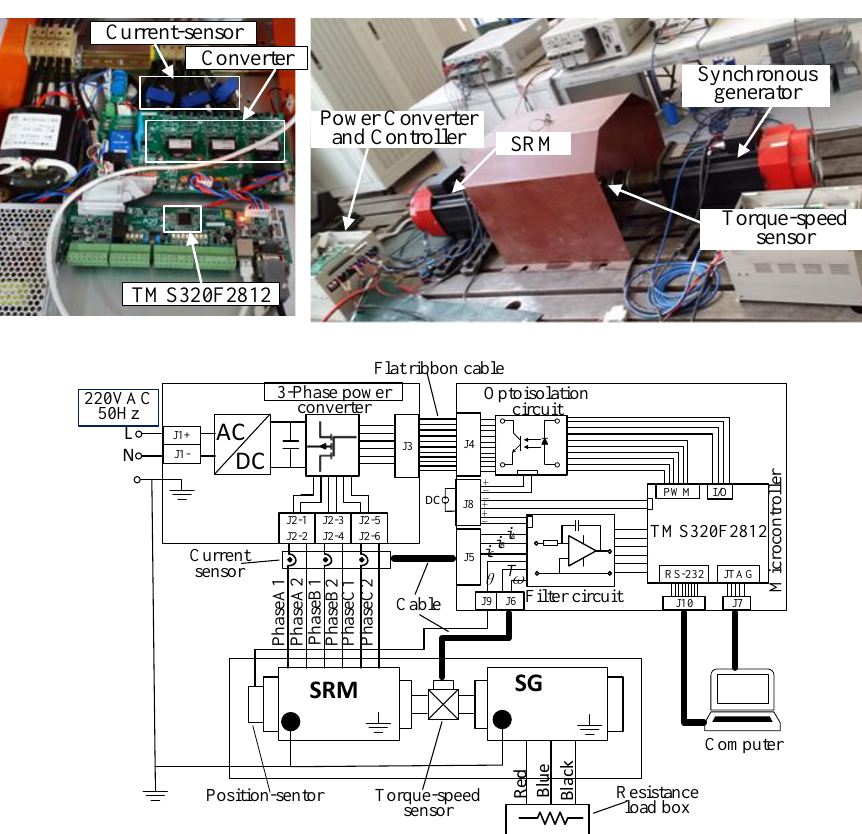
Figure 15. Experimental setup of the SRM drive system.